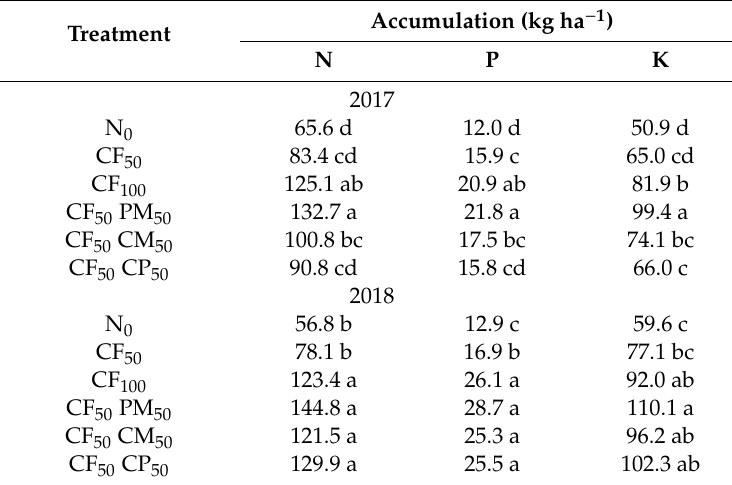
Table 4. N, P and K accumulation (kg ha − 1 ) of rice variety Manawthukha a ff ected by organic fertilizer at